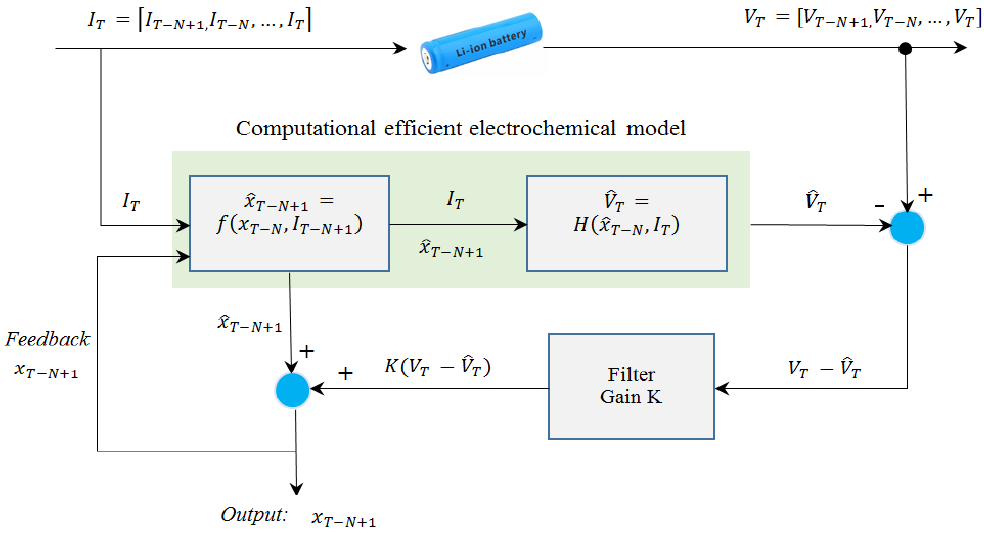
Figure 6. Moving-window filter implementation.